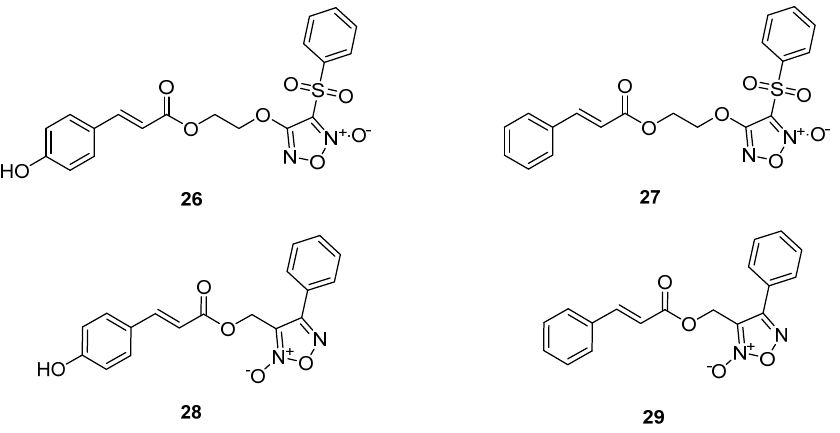
Figure 9. Chemical structure of furoxan–cinnamic acid hybrids 26–29 as antidiabetic agents. In vitro evaluation of phenylfuroxan hybrids 17a , 19a , 28 , and 29 against a-glucosidase (maltase and sucrase) from rat small intestine showed that only hybrids 17a (IC 50 = 301.73 µ M in maltase and 223.36 µ M in sucrase) and 19a (IC 50 = 123.36 µ M in maltase and 155.03 µ M in sucrase) exhibited any activity. None of the hybrids presented better inhibitory activity than acarbose (5.59 µ M in maltase and 2.31 µ M in sucrase), and hybrids 28 and 29 did not show any activity [51].